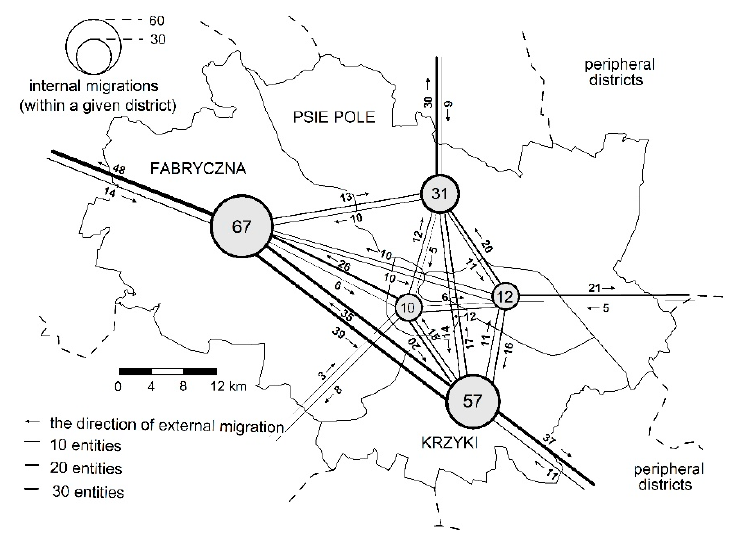
Figure 11. Internal and external migrations of industrial entities from Wrocław to its suburban area in 2008–2016 (sourced by authors).